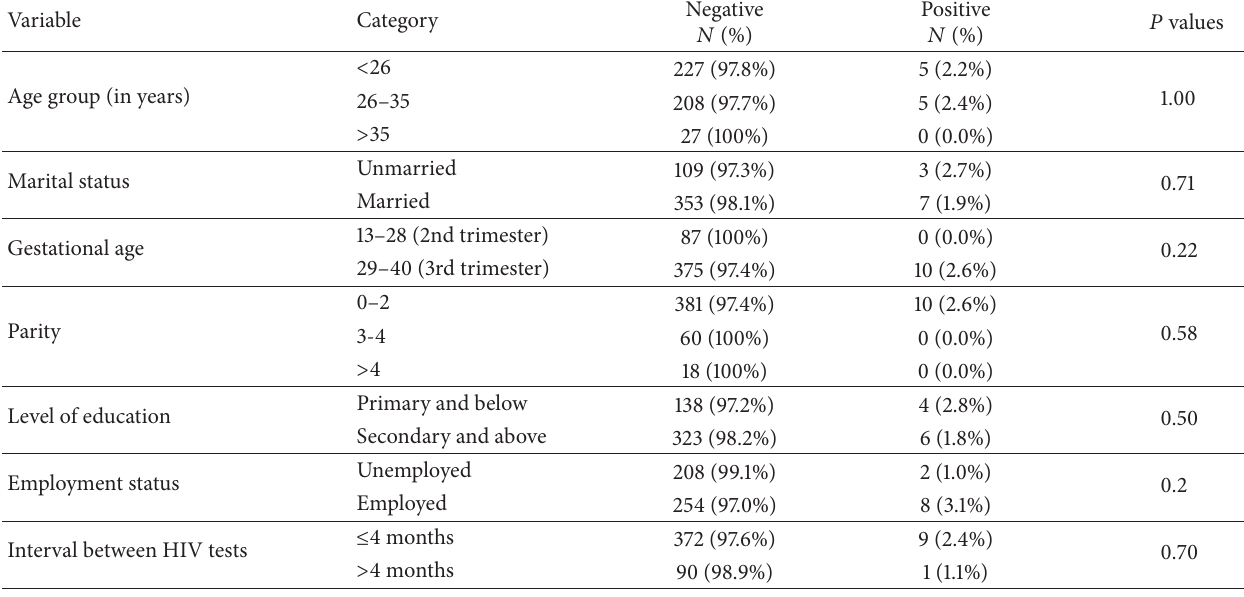
Table 5: Association between sociodemographic factors and HIV seroconversion in pregnancy.